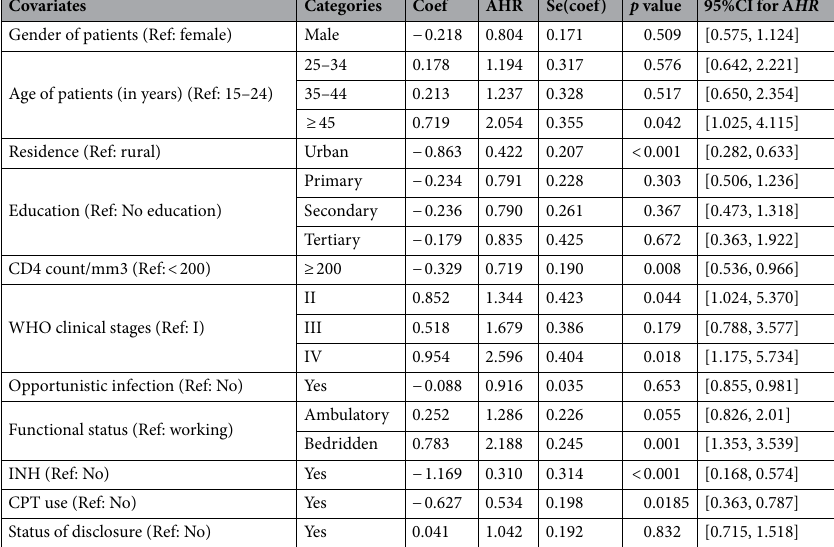
Table 4. Results of Multivariable Cox-regression analysis for predictors of survival time to death among TB/ HIV co-infected adult patients on ART at Mettu Karl Referral Hospital, Ethiopia, 2014–2022 (n = 402). Source : MKRH from 1st February 2014 to 30th January 2022, AHR: Adjusted Hazard Ratio. Coef: coefficients, AHR: Adjusted hazard ratio, Se(coef): standard error of coefficients, CI: 95% confidence interval for AHR(Adjusted Hazard